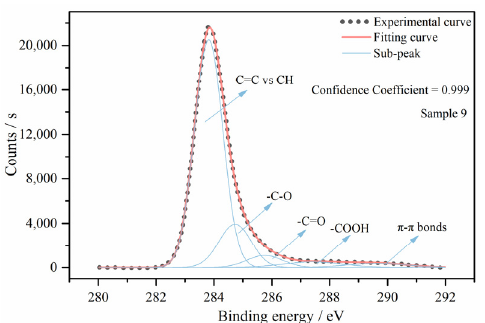
Figure 8. Curve fitting of the XPS spectrum ranging from 280 eV to 292 eV. Table 4. Assignment of C(1s) peaks (according to Perry and Grint [68] and Shi et al. [69]). Binding Energy (eV) Binding Energy (eV) Assignment